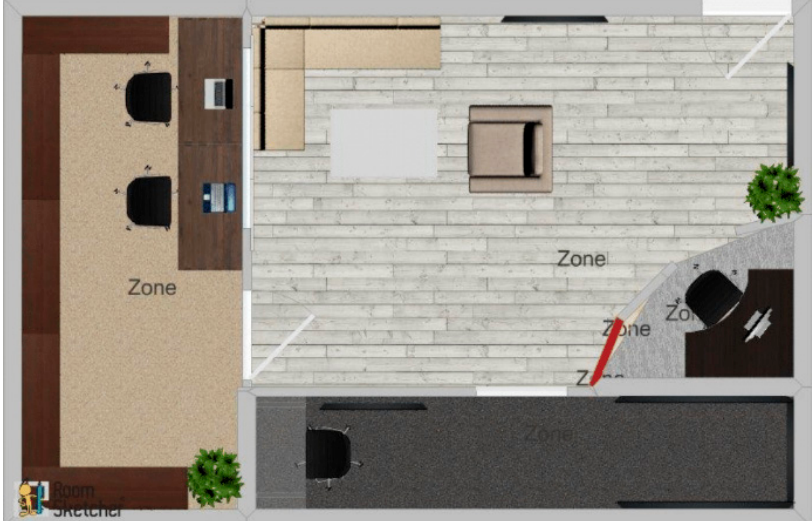
Figure 1. Original floor plans for our living